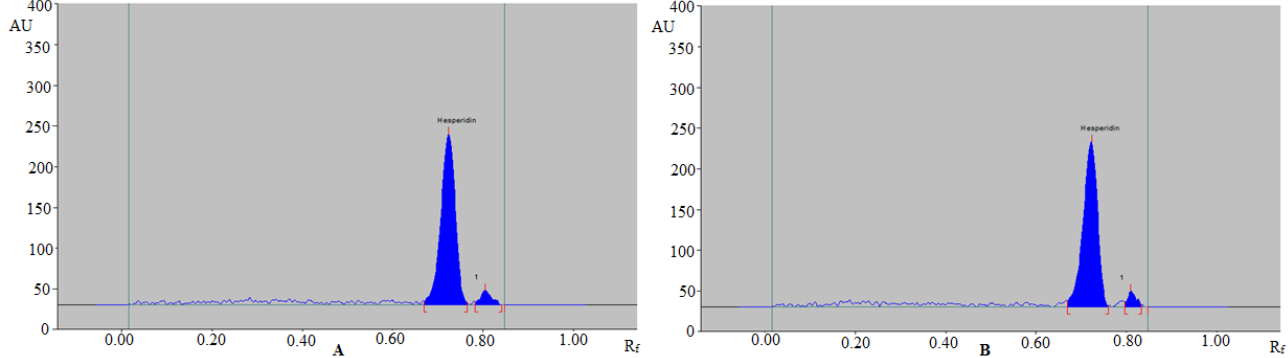
Figure 6. Spectrodensitograms of HSP in methanolic extract of ( A ) commercial formulation A and ( B ) commercial formulation B obtained using RP-HPTLC method. Table 6. Application of a sustainable RP-HPTLC method for the quantitative estimation of HSP in TE and UBE of four different varieties of citrus fruit peels and commercial formulations (mean ± SD; n = 3) .